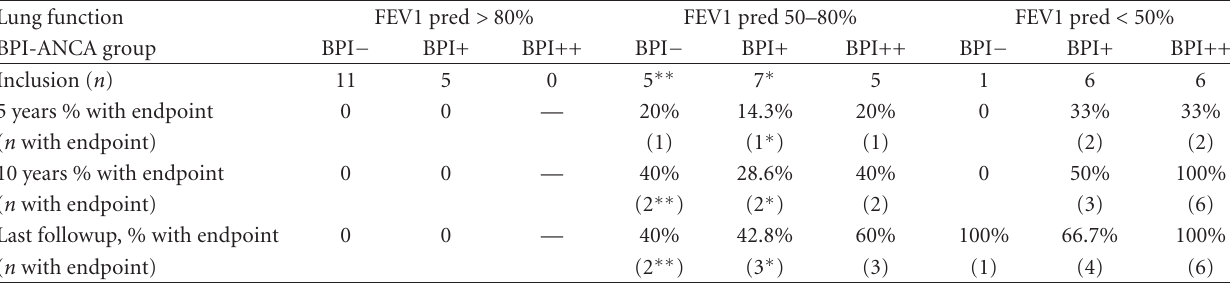
Table 3: Lung function, BPI-ANCA, and outcome. Patients divided into groups based lung function and IgA BPI-ANCA levels at baseline, and subsequent end-points during